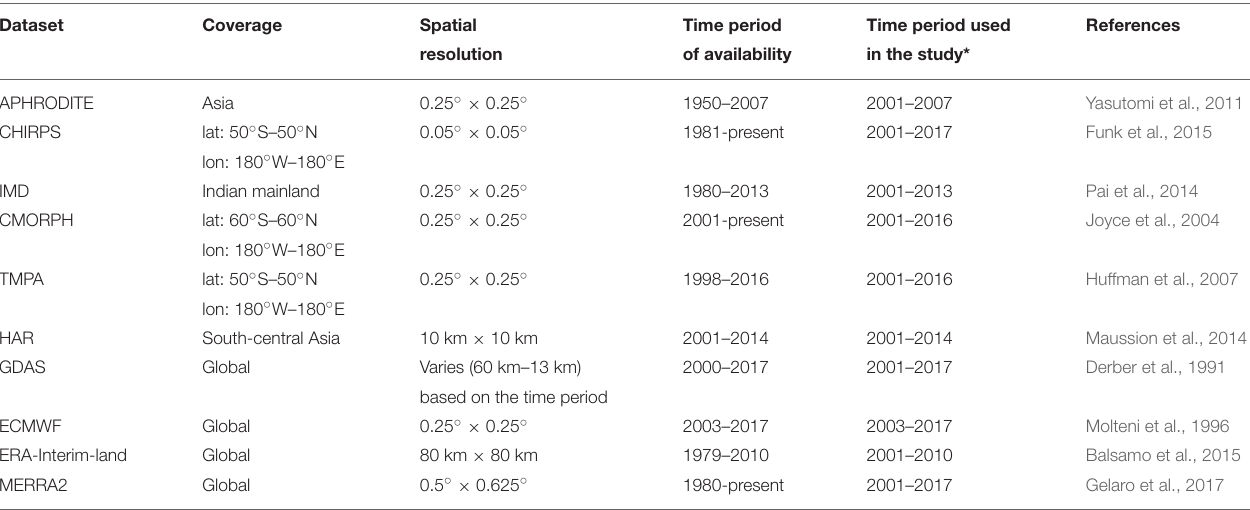
TABLE 1 | Details of the precipitation datasets evaluated in this study.